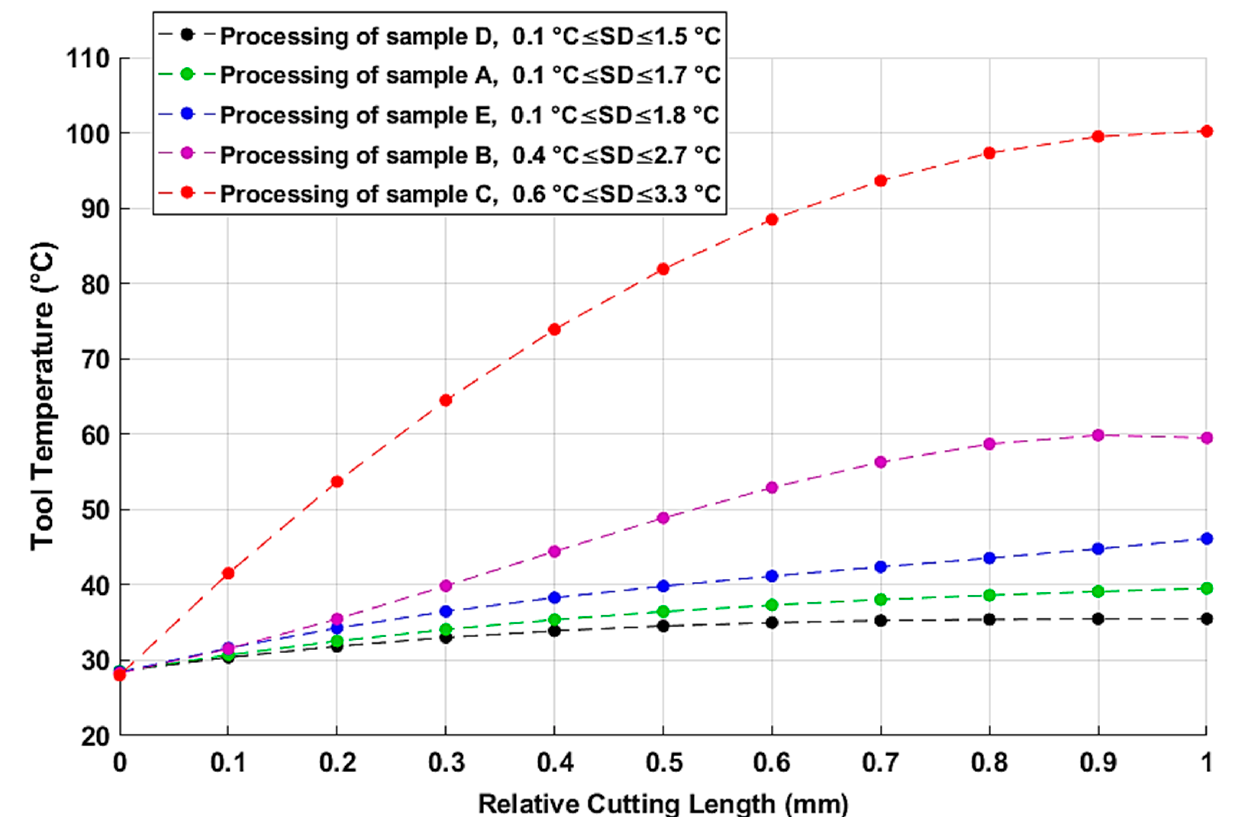
Figure 7. Tool temperature measurements over relative cutting length.